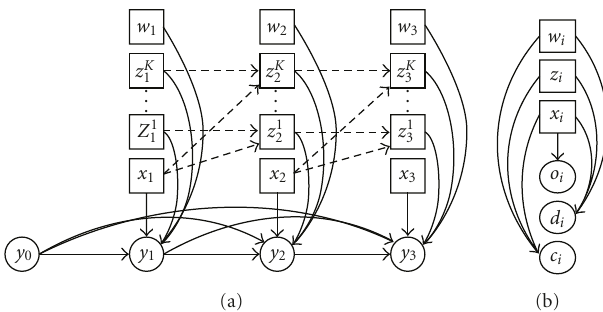
Figure 2: (a): Dynamic Bayesian networks model; (b) dependency in a single time slice. Solid arrows depict stochastic dependency; dashed arrows depicted deterministic one. Squares depict discrete random variables; circles depicted continuous ones.